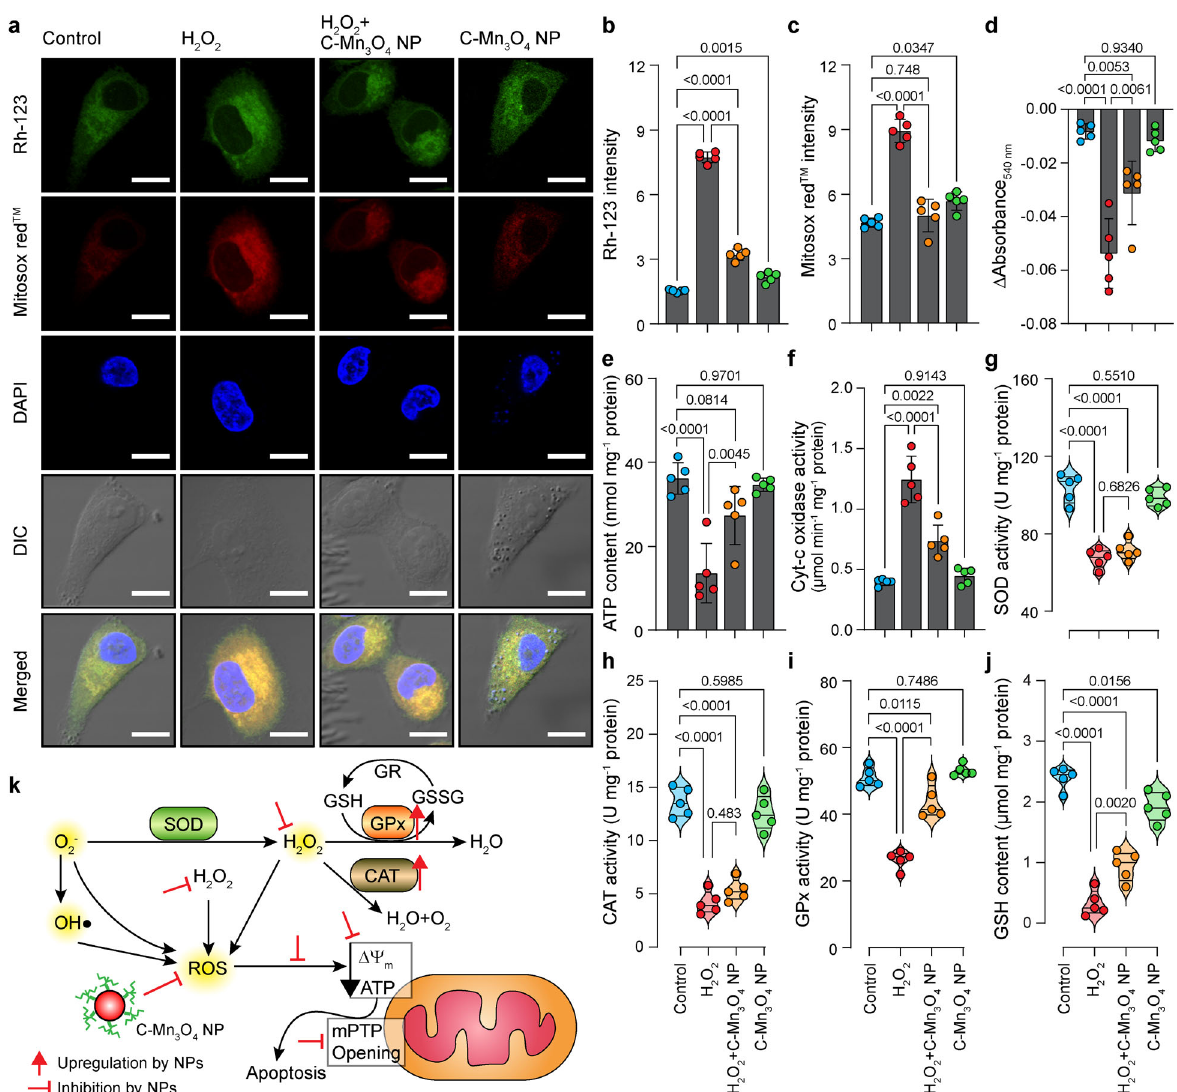
Fig. 3 Potential of C-Mn 3 O 4 NPs in the regulation of cellular redox condition and protection of mitochondria from oxidative damage. a Confocal fl uorescence micrographs of HEK 293 cells stained with rhodamine 123, Mitosox TM red, and counterstained with DAPI. Cells were either left untreated or pretreated with C-Mn 3 O 4 NPs (30 μ g mL − 1 ) prior exposure to H 2 O 2 (100 µ M). Scale bar: 10 µ m. b Intensity of rhodamine 123 as a marker of mitochondrial membrane potential ( Δψ m ). An increase in intensity indicates membrane depolarization. c Mitochondrial ROS level as quanti fi ed from Mitosox TM red fl uorescence. d Change in Ca 2 + -induced mPTP opening. e ATP content. f Cytochrome c oxidase activity. g Superoxide dismutase (SOD) activity. h Catalase activity. i Glutathione peroxidase (GPx) activity. j Reduced glutathione (GSH) content. k Schematic representation of the redox homeostasis mechanism by C-Mn 3 O 4 NPs against H 2 O 2 distress through mitochondrial protection. In bar plots data were expressed as Mean± SD. Violins depict kernel density estimation of the underlying data distribution with the width of each violin scaled by the number of observations at that Y-value. Three lines (from the bottom to the top) in each violin plot show the location of the lower quartile (25th), the median, and the upper quartile (75th), respectively. The shaded area indicates the probability distribution of the variable. Individual data points are represented as colored circles ( N = 5). One-way analysis of variance (ANOVA) followed by Tukey ’ s post hoc multiple comparison test was performed for comparison among the groups. The numbers inside the plots indicate numerical p values. p < 0.05 is considered signi fi